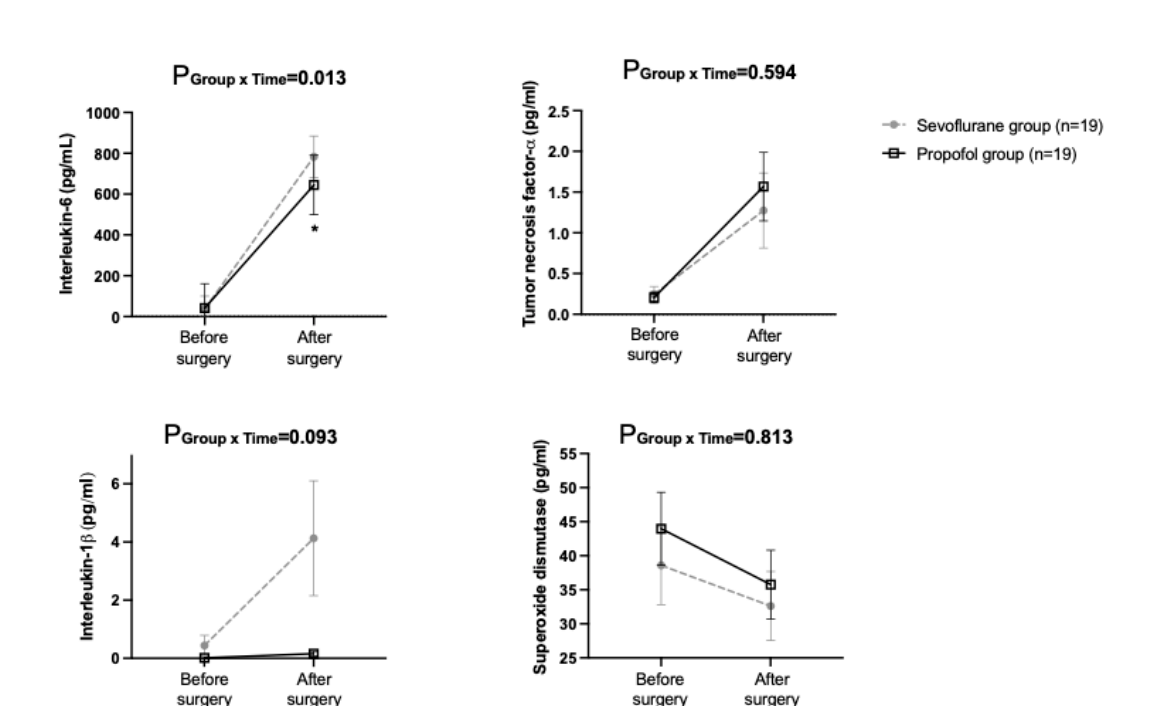
Figure 2. Serum levels of inflammatory cytokines and antioxidant enzymes. P GroupxTime = p -value of the group and time interaction obtained by the linear mixed